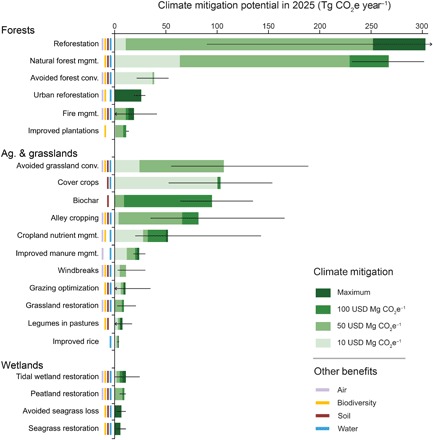
Climate mitigation potential of 21 NCS in the United States.Black lines indicate the 95% CI or reported range (see table S1). Ecosystem service benefits linked with each NCS are indicated by colored bars for air (filtration), biodiversity (habitat protection or restoration), soil (enrichment), and water (filtration and flood control). See the Supplementary Materials for detailed findings and sources.